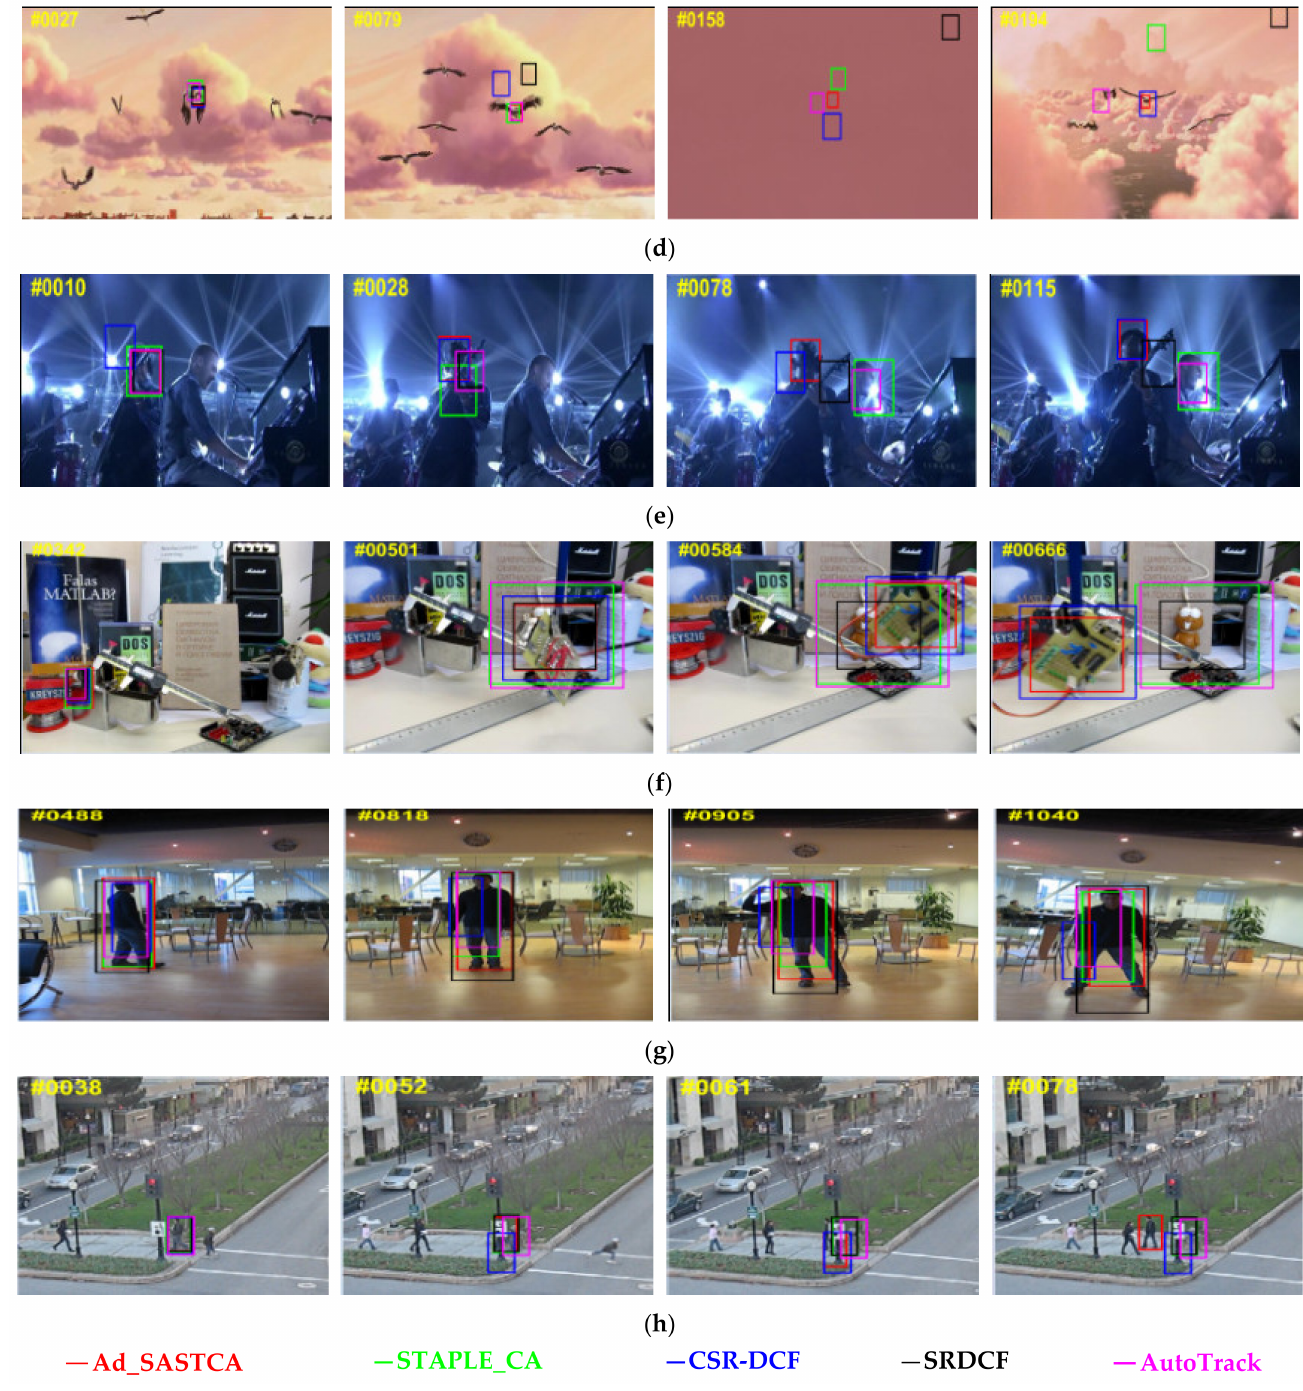
Figure 6. Illustration of qualitative tracking results on challenging sequences (From top to bottom: ( a ) lemming, ( b ) BlurOwl, ( c ) Girl2, ( d ) Bird1, ( e ) Shaking, ( f ) Board, ( g ) Human2 and ( h ) Human3). The colour bounding boxes are the corresponding results of Ad_SASTCA, STAPLE_CA [28], CSR_DCF [32], SRDCF [26] and AutoTrack